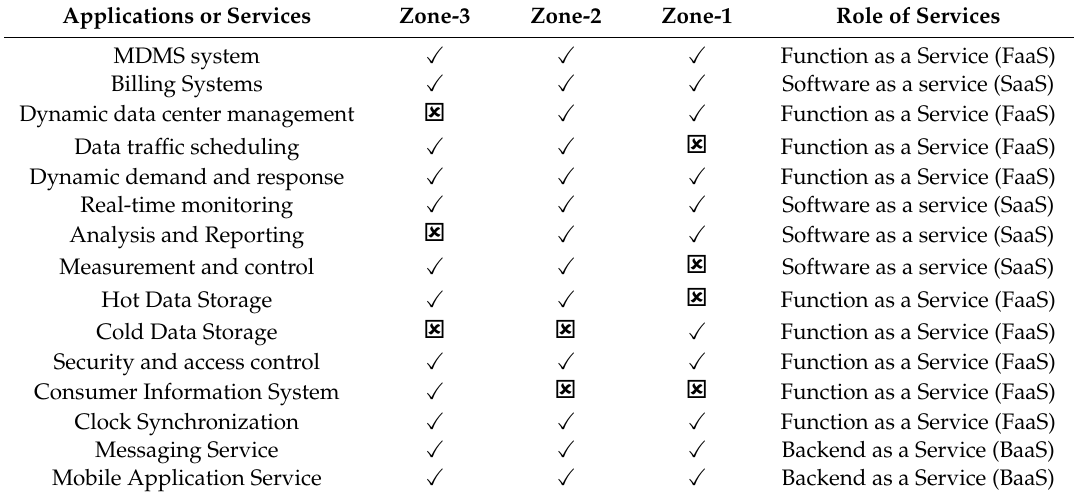
Figure 6. FC ‐ EC SG ‐ AMI zone, regions, and block of services . Table 3. The distribution of SG ‐ AMI services according to zones and the role of services.